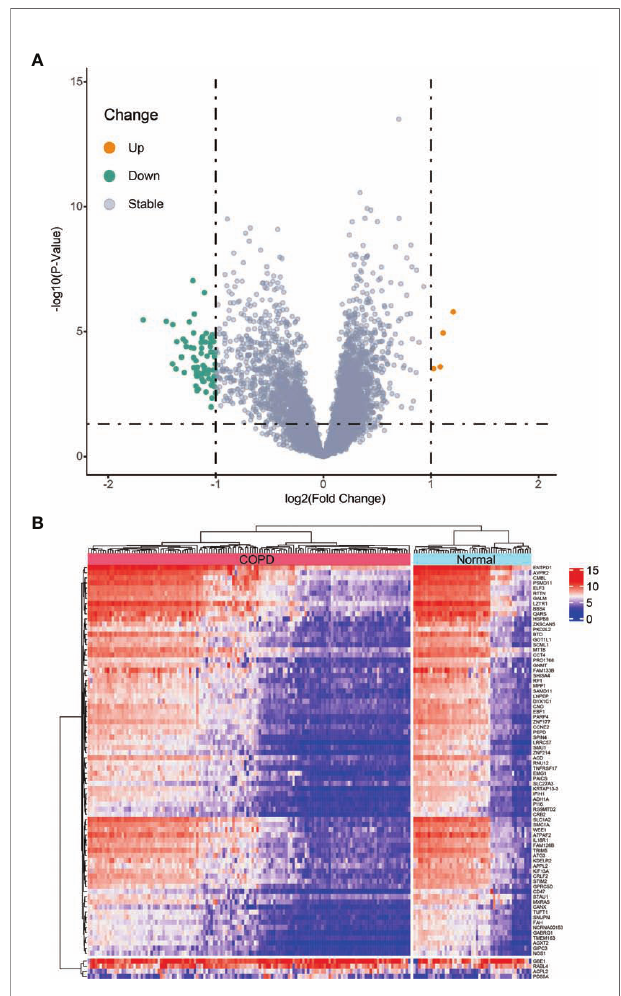
FIGURE 1 | Differentially expressed genes (DEGs) between chronic obstructive pulmonary disease tissues and normal samples in metadata (GSE38974 and GSE76925 datasets) cohort. (A) Volcano plot of DEGs; orange dots represent up-regulated differential genes, gray dots represent nonsigni fi cant genes, and green dots represent down-regulated differential genes. (B) Heatmap plot of